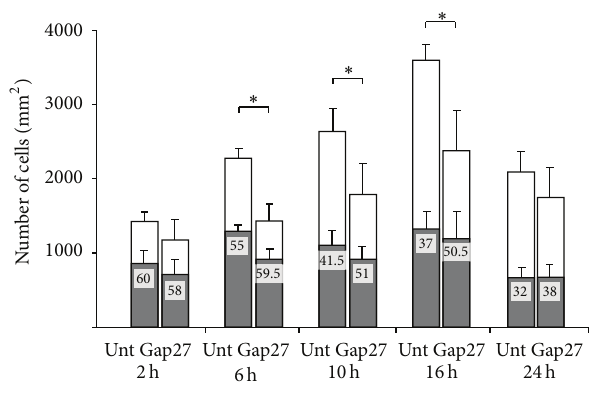
Figure 3: Testing of cell proliferation (gray columns) and prolif- erating cell fractions (numbers in gray columns in %) using Ki67 immunocytochemistry and absolute cell numbers (gray + white columns) indicating cell survival, in FDC-B cell cultures. Absolute cell numbers are significantly decreased ( ∗ 𝑃 < 0.05 ) 6h, 10h, and 16hafterGap27treatmentcomparedtotheuntreatedcultures(Unt). Proliferating cell fractions show a nonsignificant trend of reduction = 0.423 ; 𝑝 = 0.186 ; 𝑝 = 0.067 ) in at these time points ( 𝑝 6 10 h 16 h h the control cultures. Results in graphs show the mean and standard deviation of at least three independent experiments.